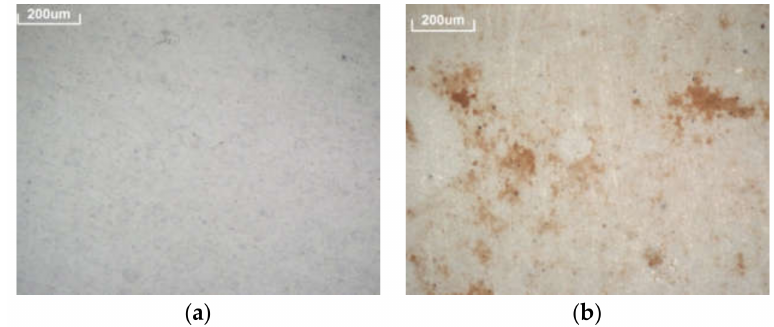
Figure 7. Paint layer of sample before ( a ) and after ( b ) the damp heat test with Ouarzazate